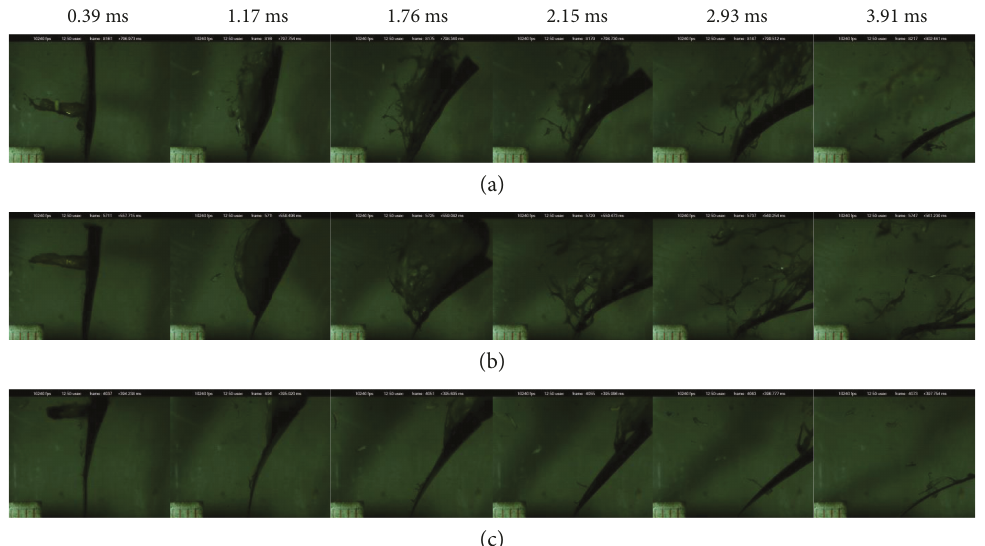
Figure 10: The bird impact process at di ff erent locations.